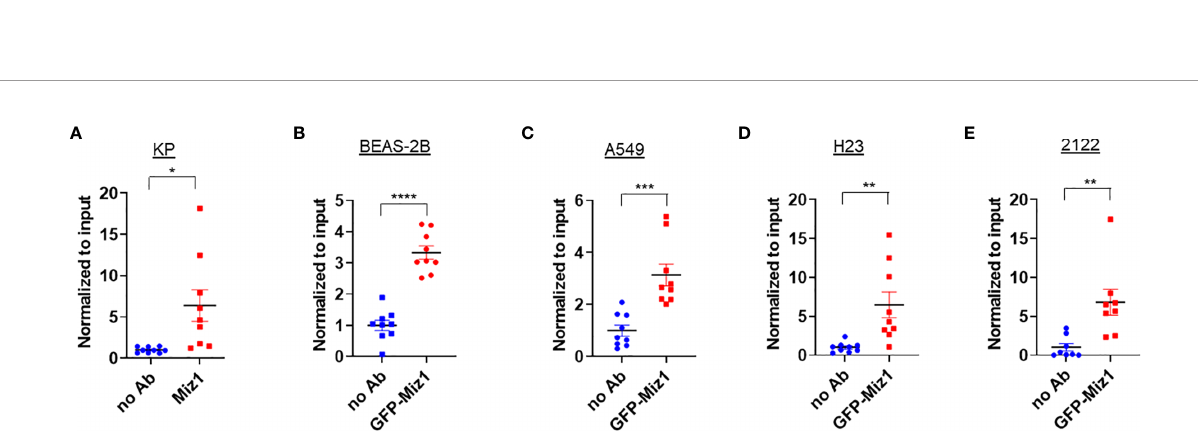
FIGURE 3 | Miz1 binds to the Ace2 promoter in both mouse and human lung epithelial cells as analyzed by ChIP-qPCR. (A – E) ChIP-qPCR shows enrichment of Miz1 binding on the Ace2 promoter as compared to no antibody (no Ab) control in KP (A) , BEAS-2B (B) , A549 (C) , H23 (D) , and 2122 (E) cells. Data are presented as means ± sem from three independent experiments. * p < 0.05, ** p < 0.01, *** p < 0.001 and **** p < 0.0001.